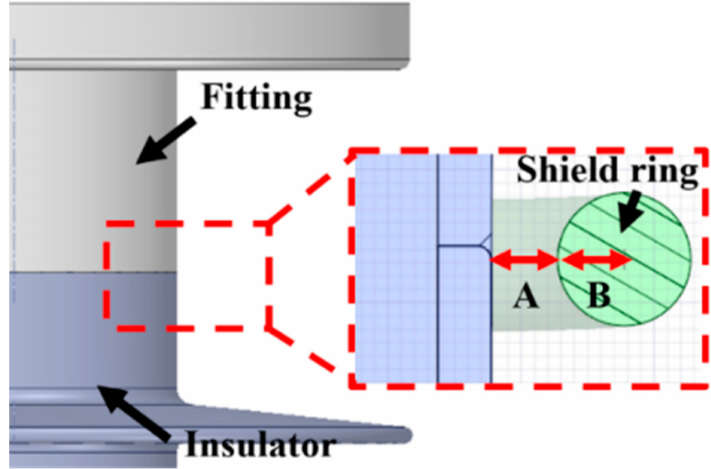
Figure 7. Design factors for the shield ring design of an